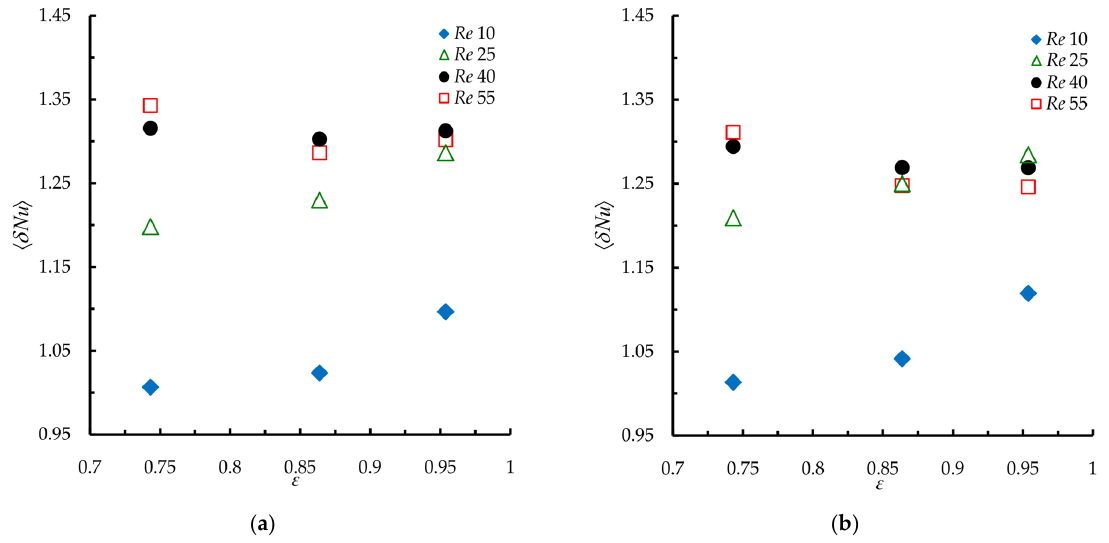
Figure 14. The effect of the porosity on the Nusselt number ratio averaged over one period of pulsation for different duty cycles: ( a ) ψ = 0.25, ( A / D s ) St = 0.268. ( b ) ψ = 0.5, ( A / D s ) St = 0.268.